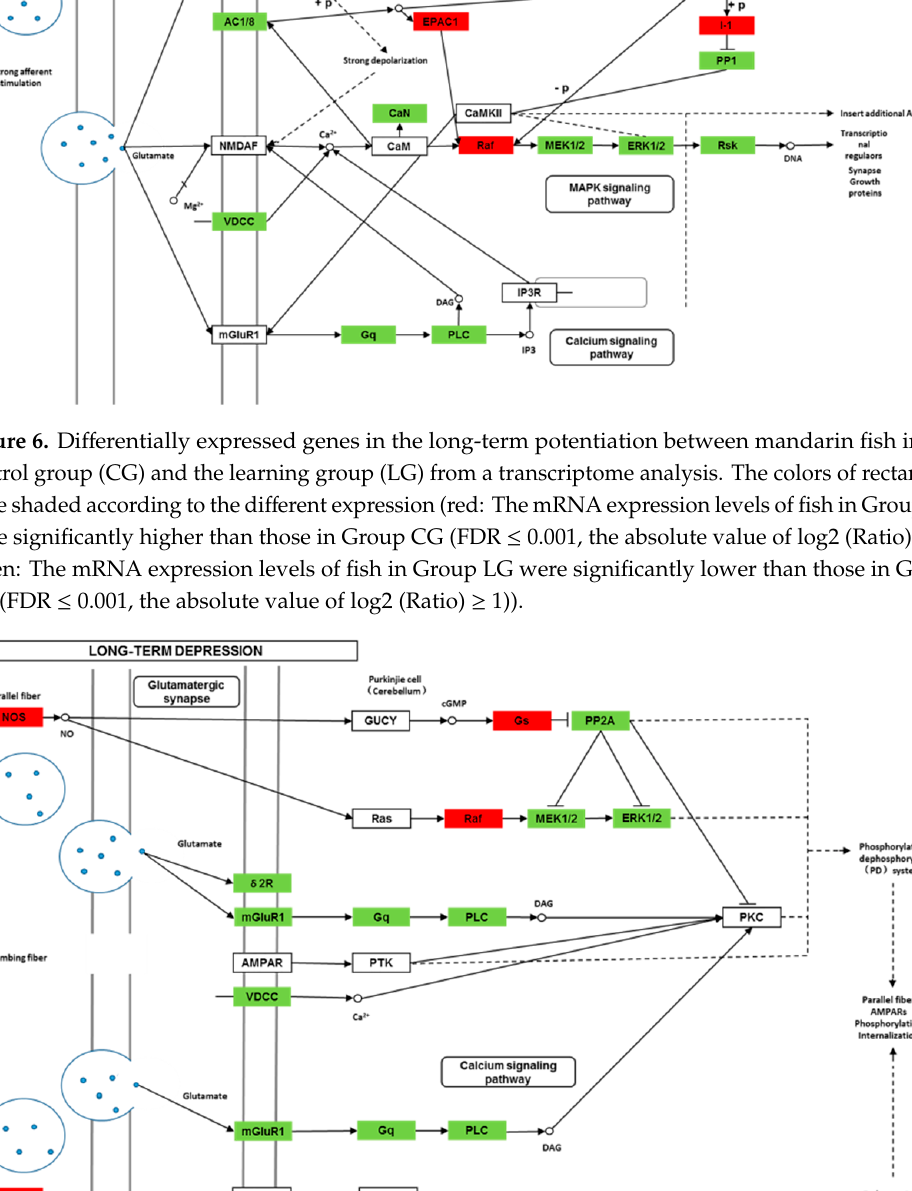
Figure 8. Differentially expressed genes in the serotonergic synapse between mandarin fish in the control group (CG) and the learning group (LG) from a transcriptome analysis. The colors of rectangles were shaded according to the different expression (red: The mRNA expression levels of fish in Group LG were significantly higher than those in Group CG (FDR ≤ 0.001, the absolute value of log2 (Ratio) ≥ 1); green: The mRNA expression levels of fish in Group LG were significantly lower than those in Group CG (FDR ≤ 0.001, the absolute value of log2 (Ratio) ≥ 1)).